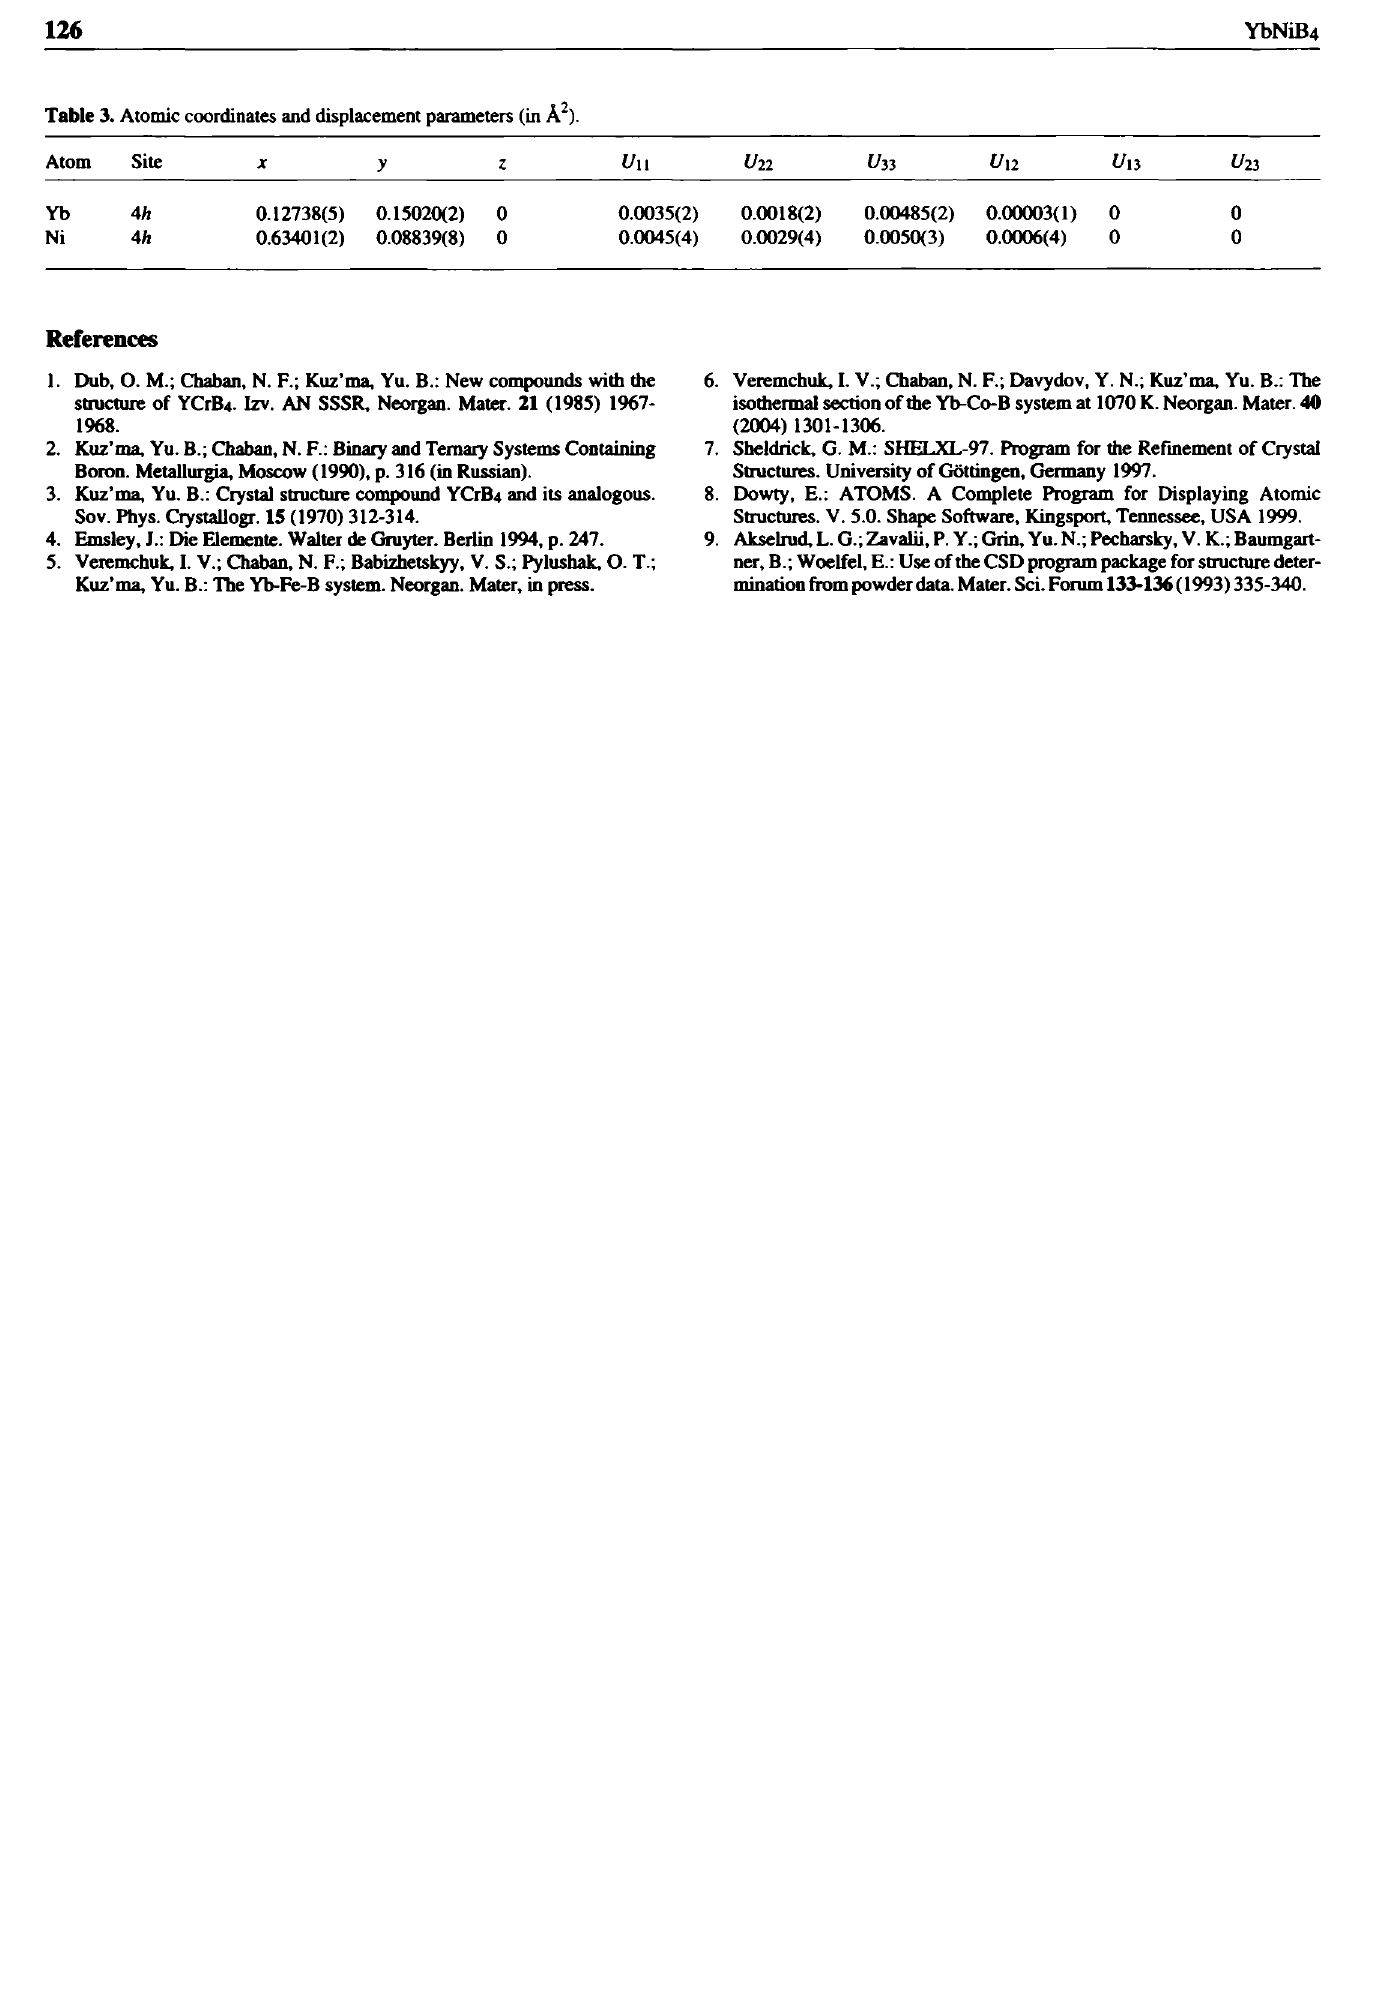
Table 3. Atomic coordinates and displacement parameters (in A 2